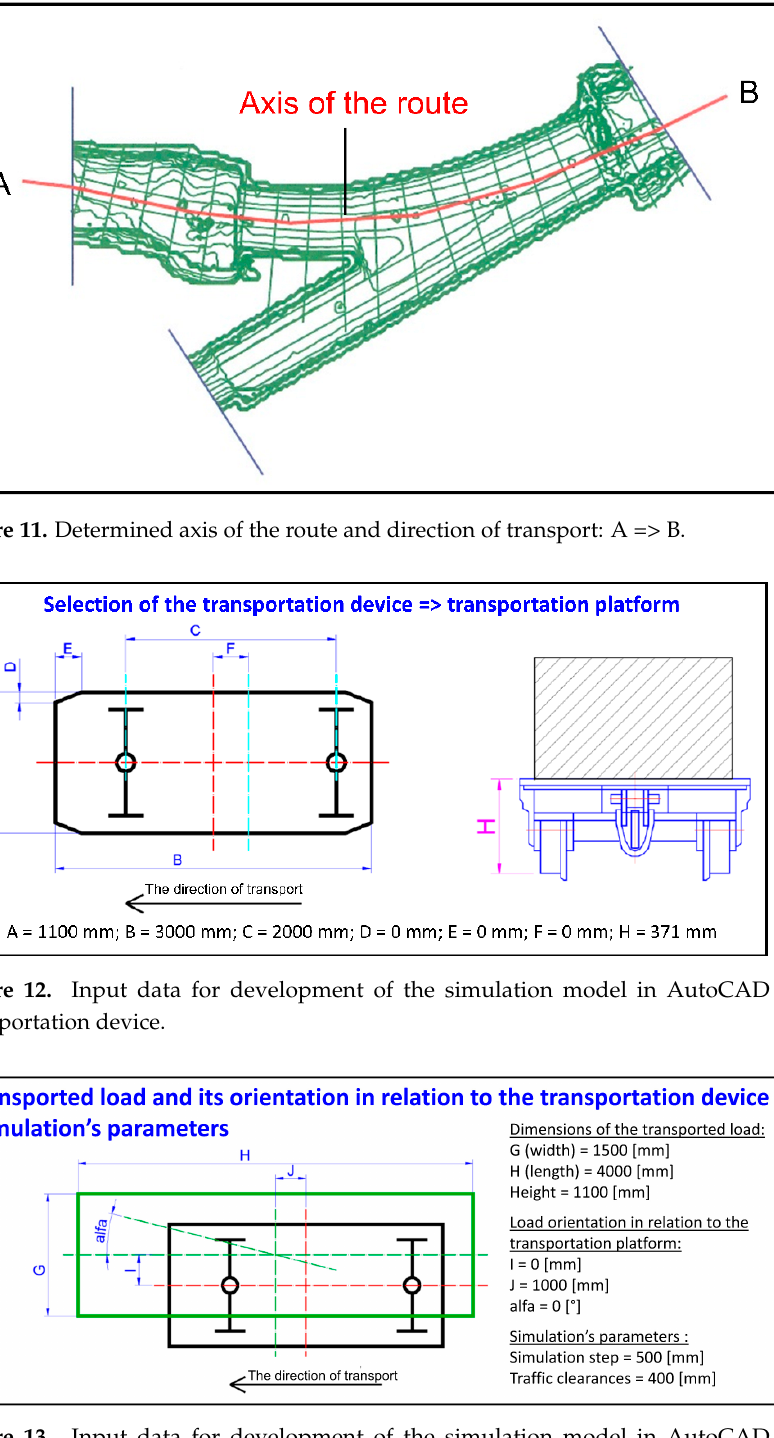
Figure 13. Input data for development of the simulation model in AutoCAD environment—transported load and simulation’s parameters.